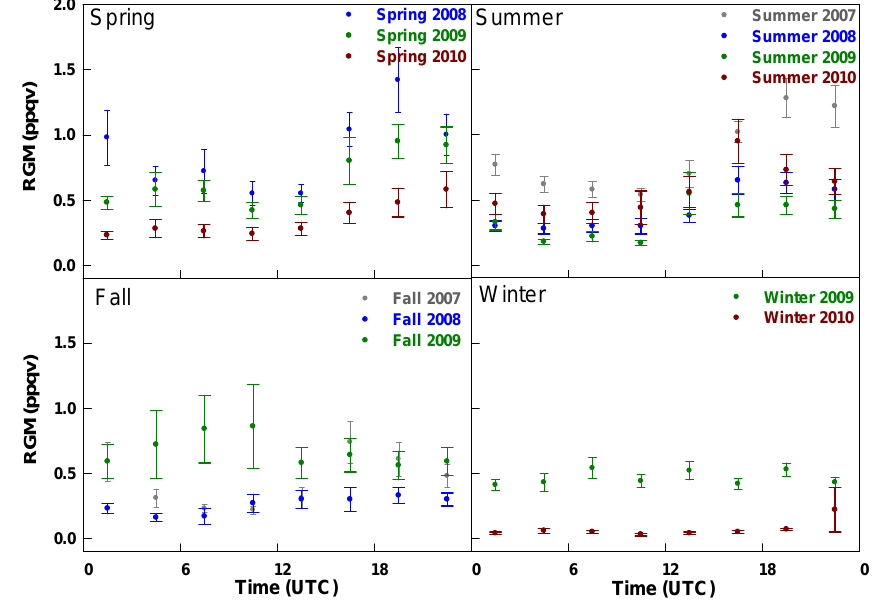
Figure 9: Seasonally averaged diurnal cycles of RGM with standard deviation of Fig. 9. Seasonally averaged diurnal cycles of RGM with standard deviation of means at AI. means at AI. shown). The strongest diurnal variation occurred in springs 2007, 2008, and 2009 at TF, with daily amplitude exceed- ing 1 ppqv compared to 0.2–0.3 ppqv in other seasons. The highest seasonal average diurnal maxima also occurred in the same seasons reaching up to 1.7 ppqv, while daily maxima varied between the LOD and 0.7 ppqv in all other